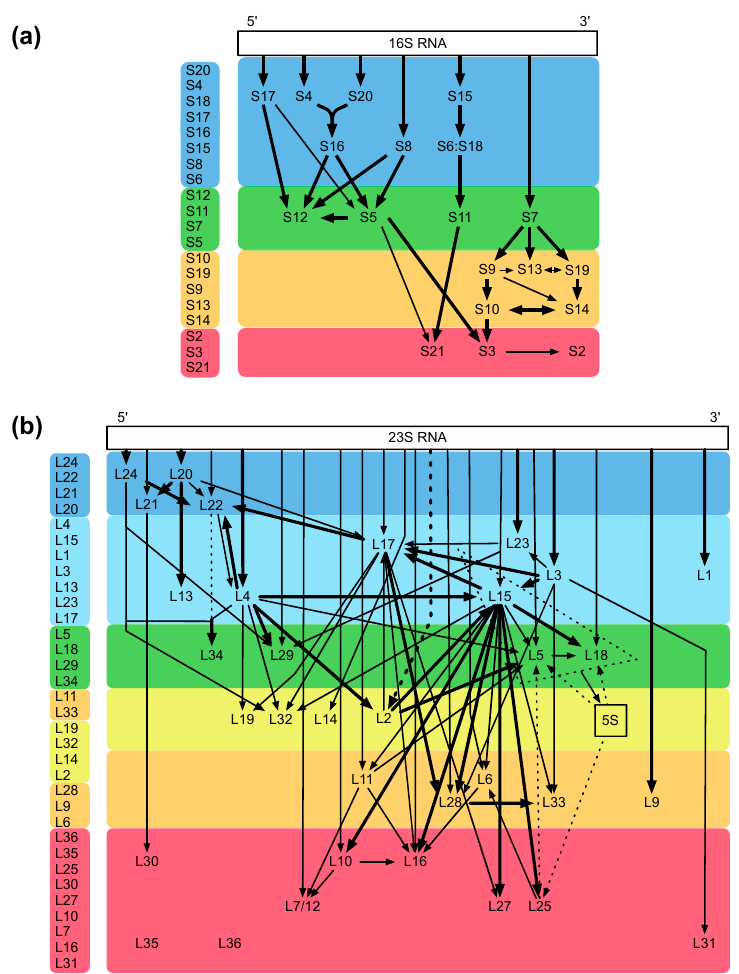
Figure 3. Assembly maps. ( a ) map of the small 30S subunit; ( b ) map of the large 50S subunit. The maps of Nomura (a) and Nierhaus (b) are color coded from blue to red according to their appearance during the assembly process in vivo , modified from Reference [28]. The assembly maps showing the assembly dependencies of the ribosomal proteins during the total reconstitution in vitro demonstrate an excellent agreement with the in vivo data. Please check if there is copyright issue.